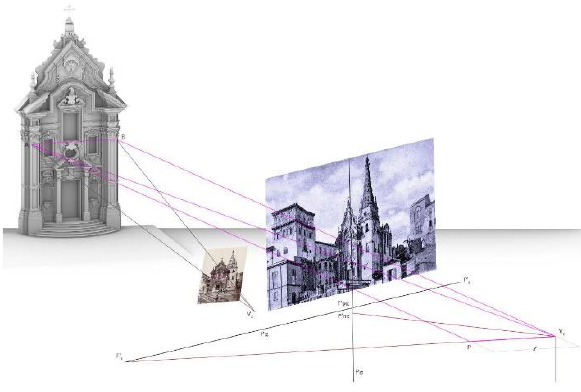
Fig. 1: 3D perspective restitution from period